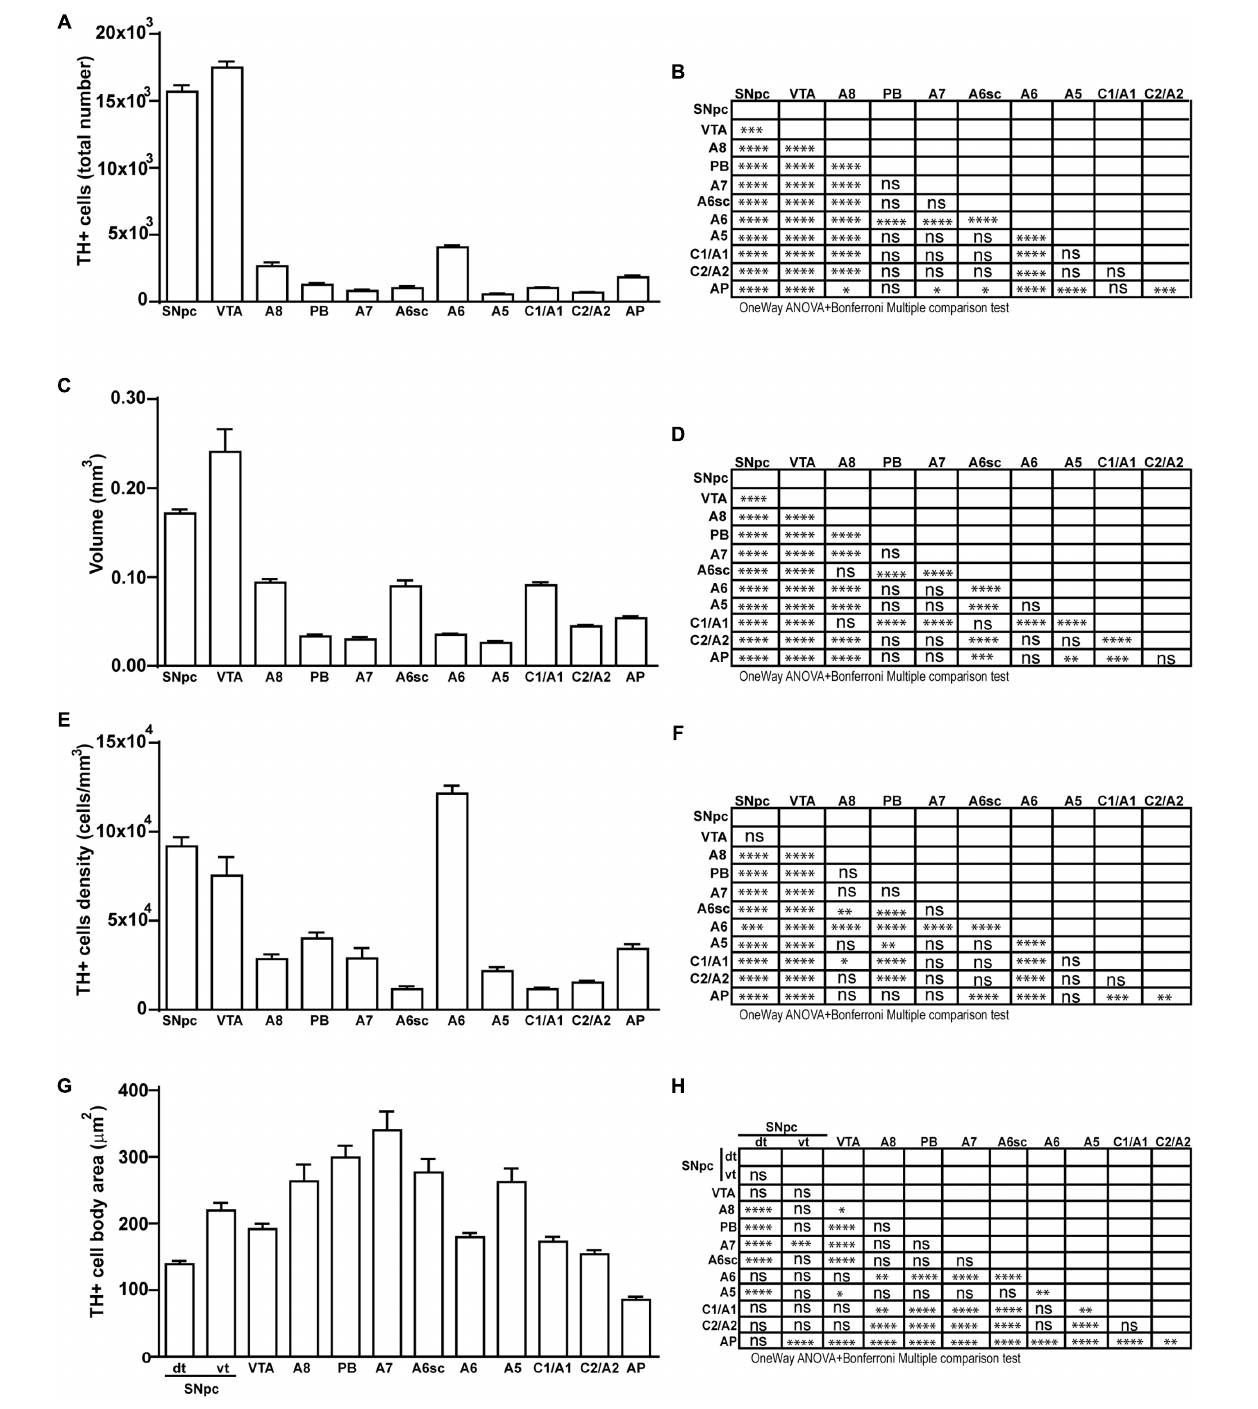
FIGURE 11 | Total number, volume, density, and cell body area of TH positive nuclei. (A) Stereological analysis of TH-positive cells. (B) Statistical analysis (one-way ANOVA plus Bonferroni); ∗ p < 0.05; ∗∗ p < 0.01; ∗∗∗ p < 0.001; ∗∗∗∗ p < 0.0001. (C) Volumetric quantification of each cathecholaminergic nucleus obtained with the Cavalieri’s method. (D) Statistical analysis (one-way ANOVA plus Bonferroni); ∗ p < 0.05; ∗∗ p < 0.01; ∗∗∗ p < 0.001; ∗∗∗∗ p < 0.0001. (E) TH-positive cell density (cells/mm 3 ). (F) Statistical analysis (one-way ANOVA plus Bonferroni); ∗ p < 0.05; ∗∗ p < 0.01; ∗∗∗ p < 0.001; ∗∗∗∗ p < 0.0001. (G) TH-positive cell body area ( µ m 2 ). (H) Statistical analysis (one-way ANOVA plus Bonferroni); ∗ p < 0.05; ∗∗ p < 0.01; ∗∗∗ p < 0.001; ∗∗∗∗ p <